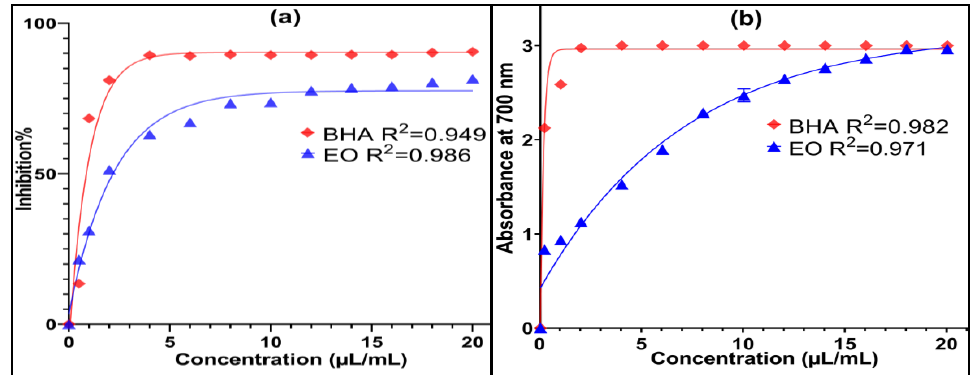
Figure 3. Antioxidant activity of the EO of O. elongatum and BHA standard by DPPH ( a ) and FRAP ( b ) methods.